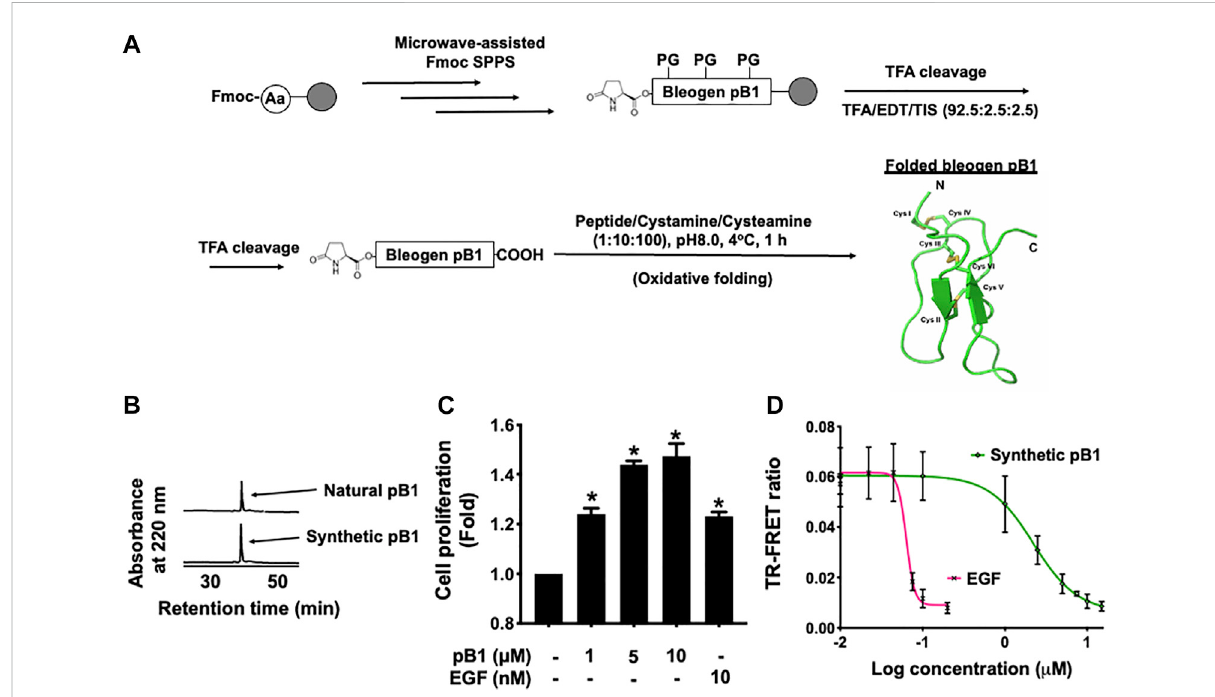
FIGURE 2 (A) Schematic overview of the chemical synthesis and oxidative folding of bleogen pB1 with N-terminal pyroglutamate. Synthetic bleogen pB1withN-terminal pyroglutamatewassynthesizedbyemploying microwave-assistedsolid-phaseFmocchemistryonanHMPB-ChemMatrixresin (PG: Protecting Group). After tri fl uoroacetic acid (TFA) cleavage, the assembled linear precursor was released from the resin support and was subjected to oxidative folding in 0.1 M ammonium bicarbonate (at pH 8.0) and 10% dimethyl sulfoxide (DMSO) with a mixture of the redox reagents cysteamine/cystamine (at a 10:1 M ratio) for 1 h. (B) Elution of natural and synthetic bleogen pB1 by using reversed-phase high- performance liquid chromatography (RP-HPLC) (C) Effects of synthetic bleogen pB1 and epidermal growth factor (EGF) on HaCaT cells for 72 h, as assessed by using a crystal violet assay. All results are expressed as the mean ± standard deviation (SD); *: p < 0.05 as compared with the control. (D) Time-resolved fl uorescence energy transfer (TR-FRET)-based competitive displacement of biotin-EGF from the EGF receptor (EGFR) after